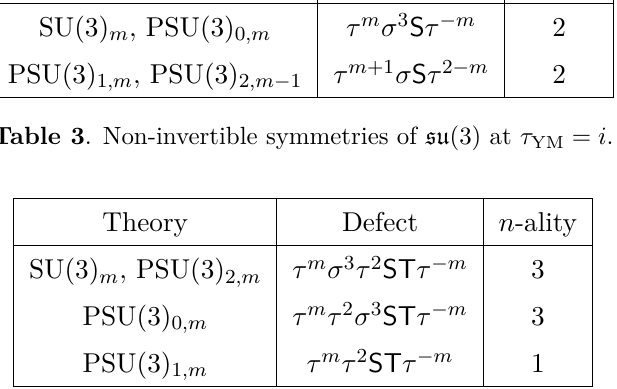
Table 4 . (Non-)invertible symmetries of su (3) at τ YM = e 2 πi/ 3